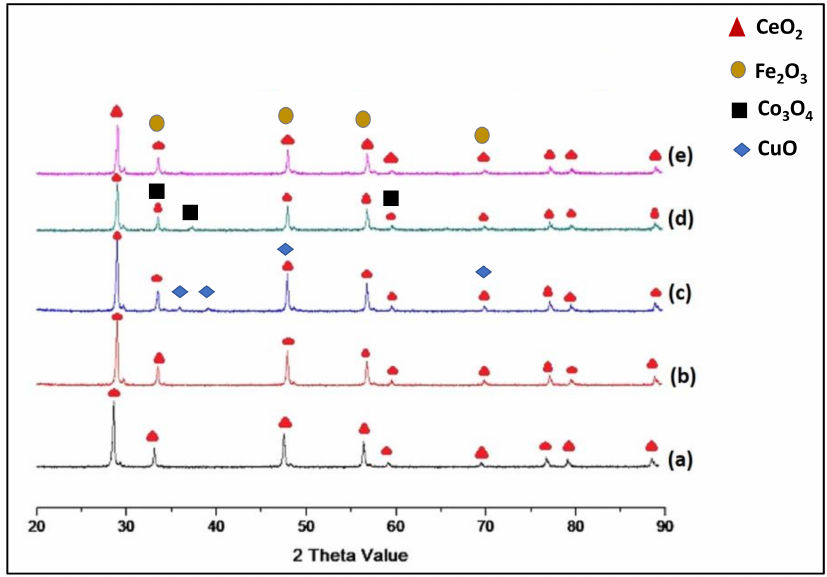
Figure 1. X-ray powder diffraction patterns of ( a ) CeO 2 , ( b ) Pd/CeO 2 , ( c ) Pd-CuO/CeO 2 , ( d ) Pd- Co 3 O 4 /CeO 2 , and ( e ) Pd-Fe 2 O 3 /CeO 2